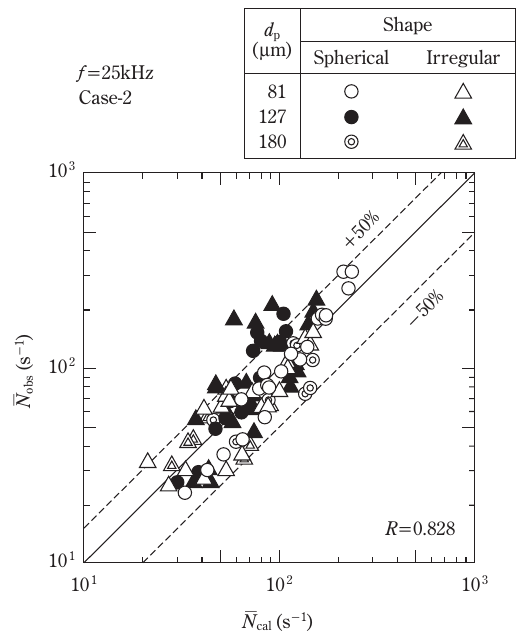
Fig. 10 Average discharge rate ( N (cid:3) ) data obtained by calculation using Eq. (9) ( N (cid:3) cal ) and experimental observation ( N (cid:3) obs